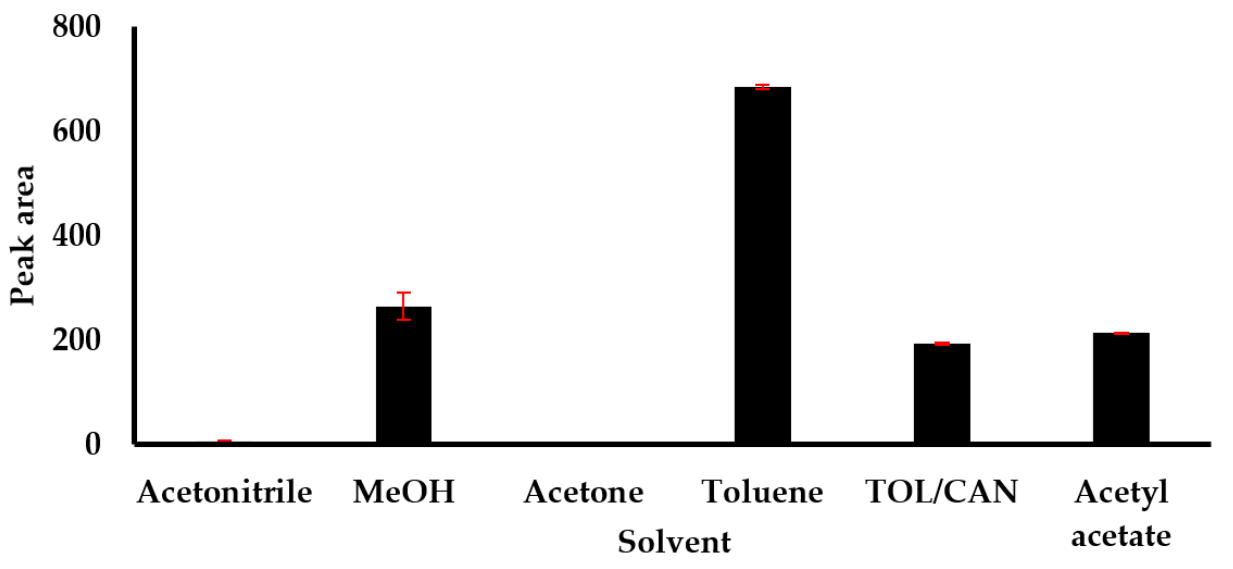
Figure 2. Efficiency of extraction solvent in the recovery of fullerenes.